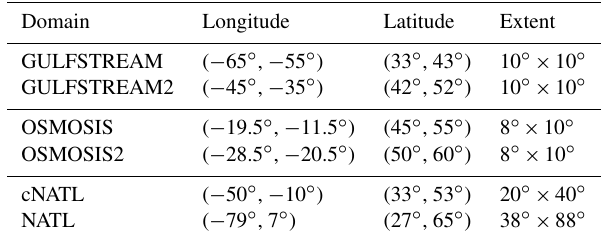
Table 1. Description of the NATL subdomains used for assessing 4DVarNet capabilities